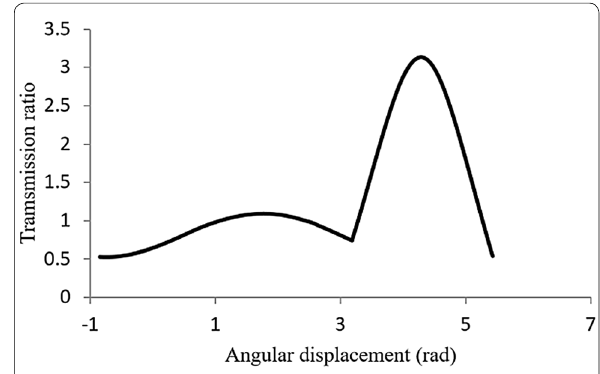
Figure 11 The total transmission